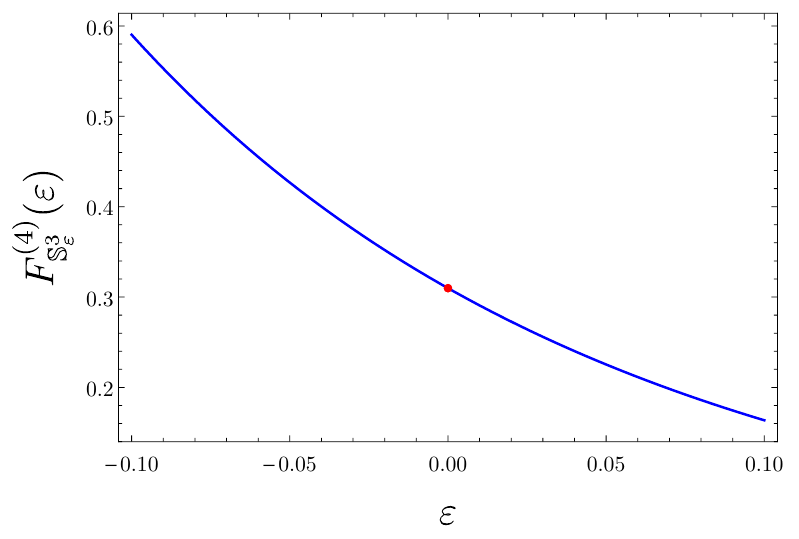
Figure 2 . Comparison of analytical prediction for F (4) derivative computed from interpolation of raw numerical data for F S 3